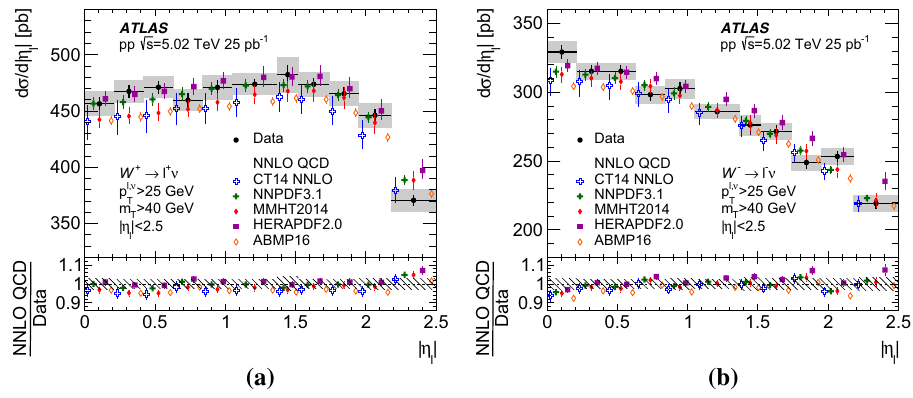
Fig. 11 Differential cross sections for a W + and b W − boson produc- tion as a function of absolute decay lepton pseudorapidity compared with theoretical predictions. Statistical and systematic errors are shown as corresponding bars and shaded bands on the data points. The lumi- nosityuncertaintyisnotincluded.Onlythedominantuncertainty(PDF)